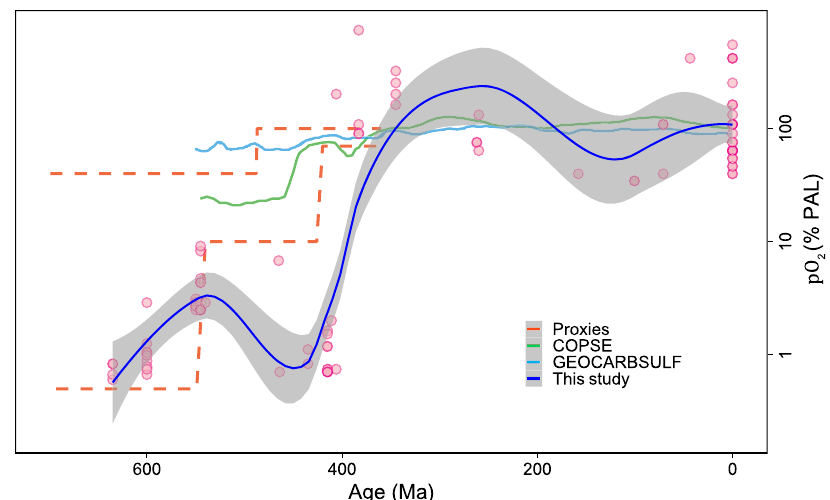
Fig. 3 The estimated partial pressure of atmospheric oxygen level pO 2 (% PAL) during the Phanerozoic Eon compared to the results of other studies 12,33 . The blue line shows our best estimate, and the gray fi eld indicates the upper and lower bounds based on 95% con fi dence level using the LOESS curve fi tting method. The pO 2 was calculated using the lowest 10% of all carbonate Ce/Ce* data for 100 Ma intervals during the Phanerozoic